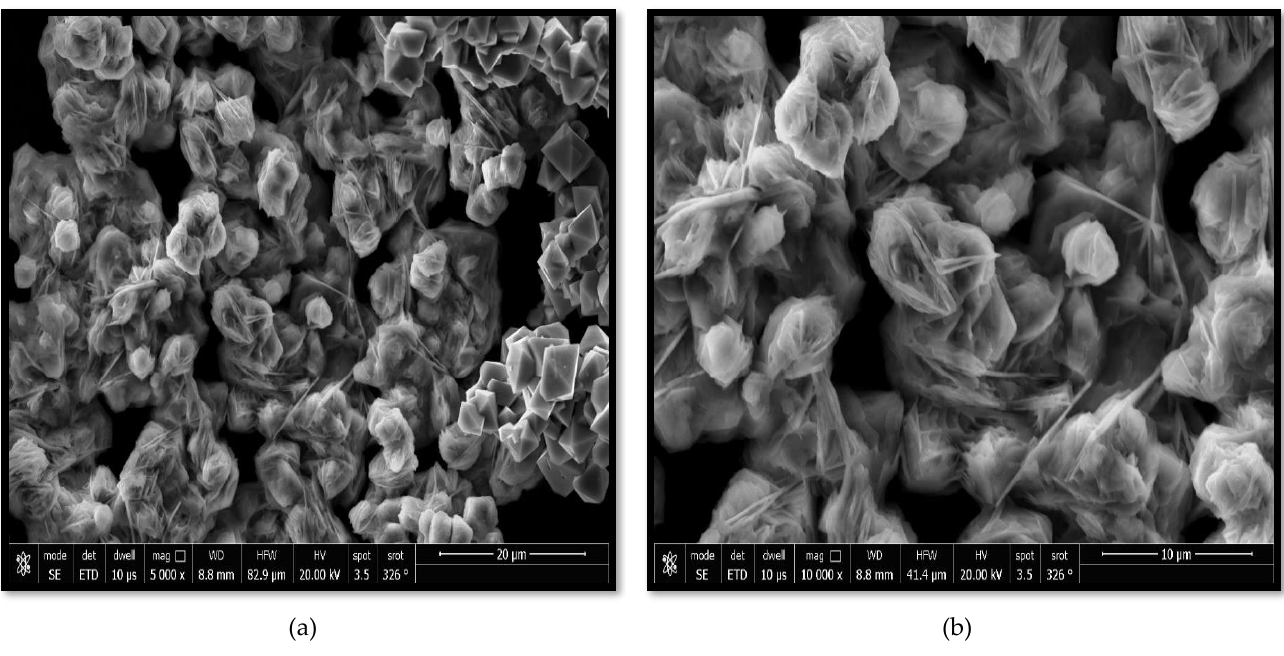
Figure 5. ( a , b ) Scanning electron microscopy images of Co 3 O 4 NPs synthesized using rosemary leaf extract at different magnifications.